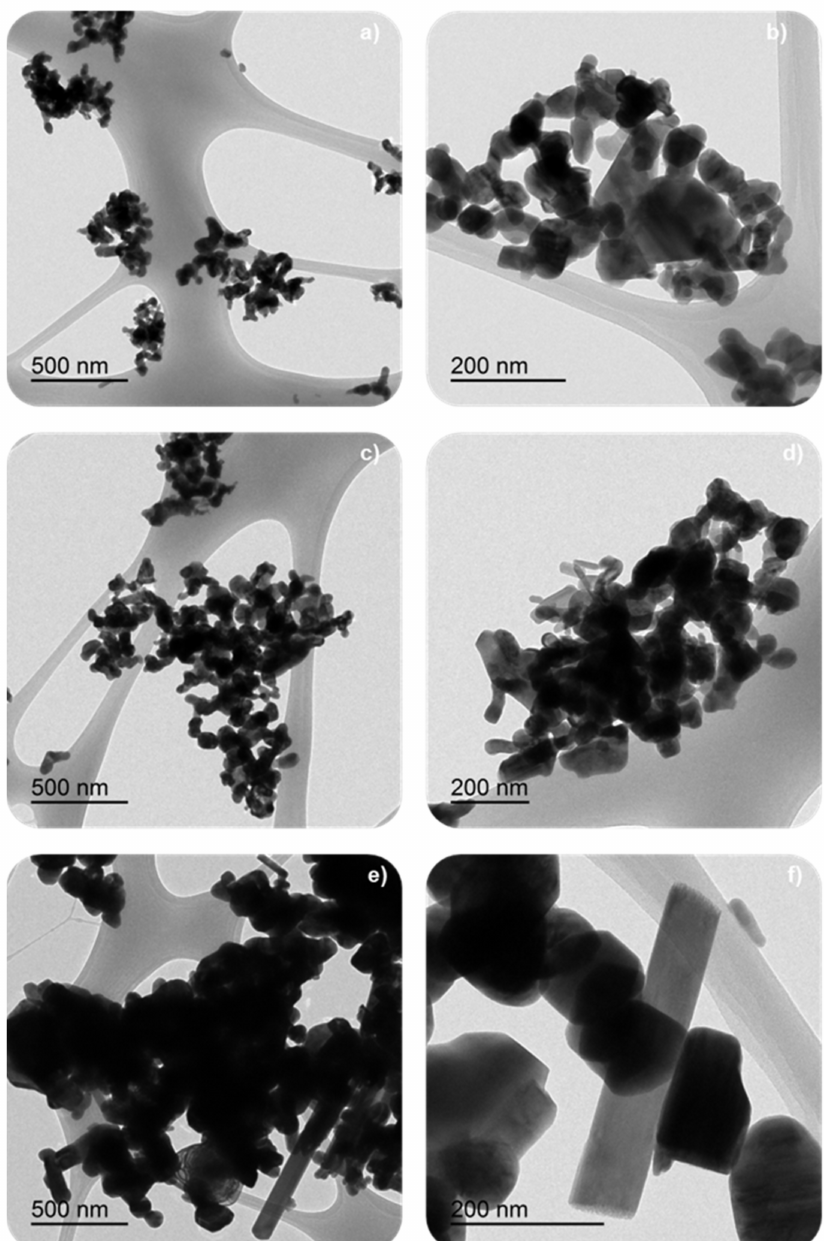
Figure 3. TEM images of some BM-CX catalyst series using different magnifications: ( a , b ) BM-C600,